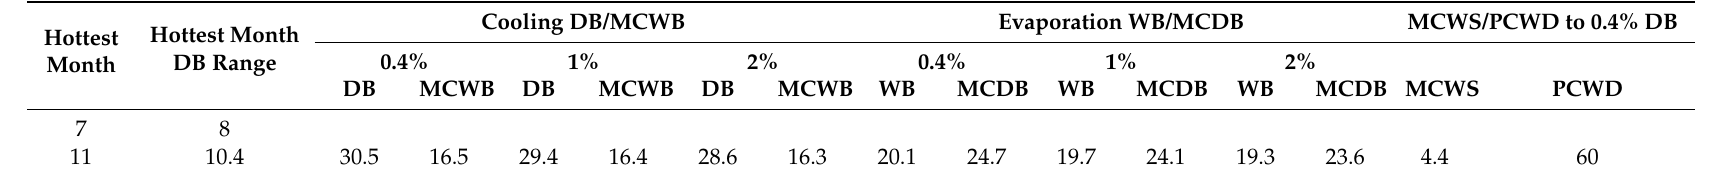
Table 5. Climatic design conditions (b) for Harare, Zimbabwe [44].